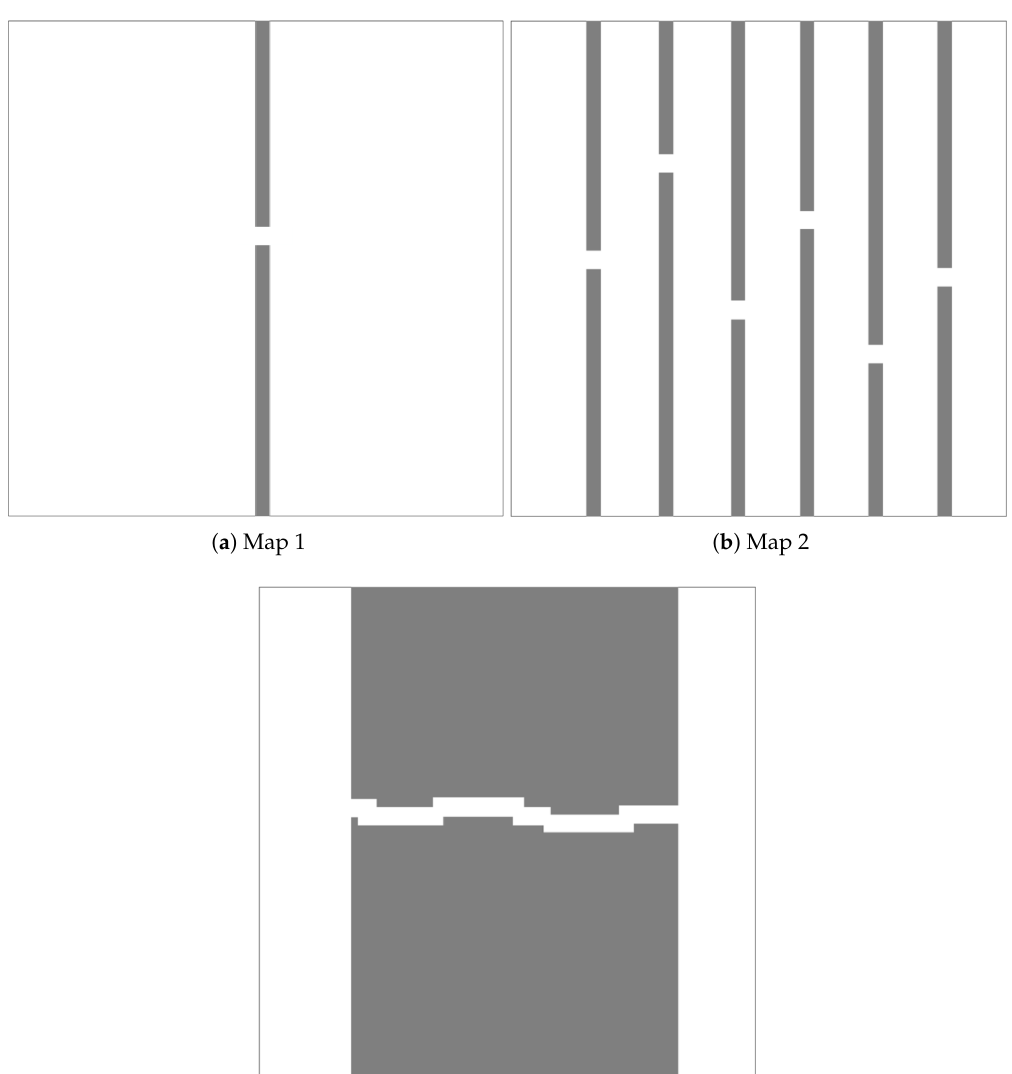
Figure 8. Three different maps with narrow passages. Map 2 has five more narrow passages than Map 1, and the narrow passage in Map 3 is longer than that in Map